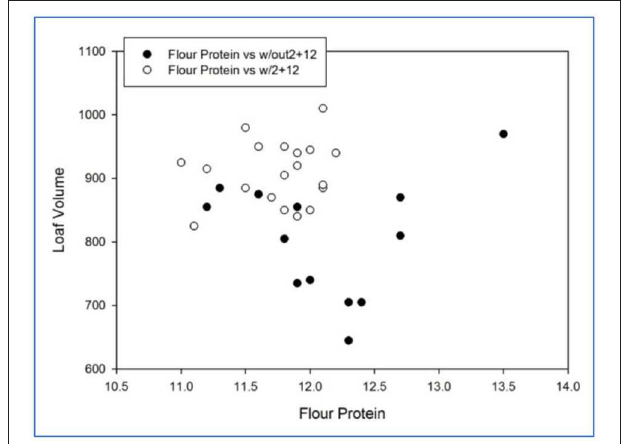
FIGURE 1 | Bread loaf volume of soft durum lines with or without Dx2 + Dy12 (flour protein in percent, loaf volume in cm 3 ).